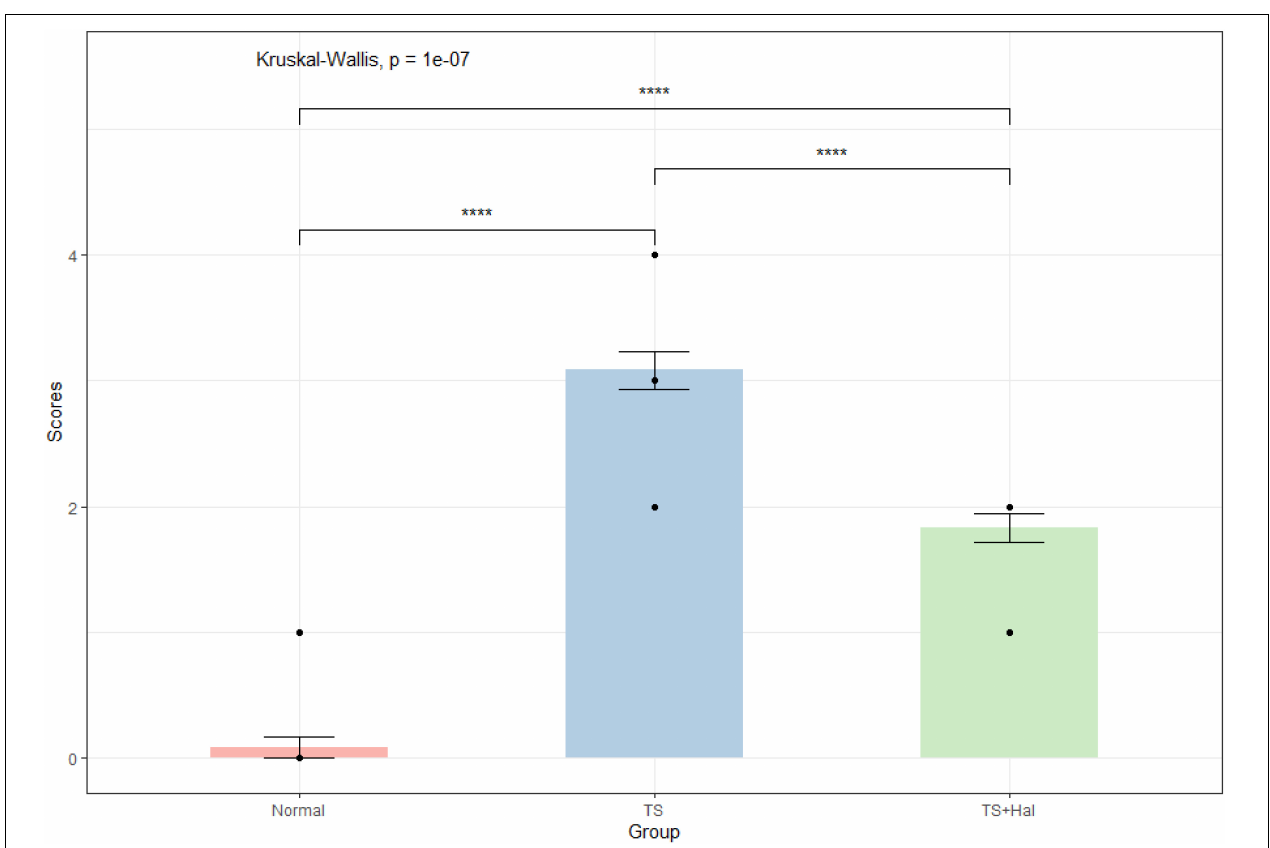
FIGURE 1 | Comparison of behavioral scores in each group. TS, Tourette syndrome; TS + Hal, TS + haloperidol group; (cid:70) (cid:70) (cid:70) (cid:70) : P < 0.001.